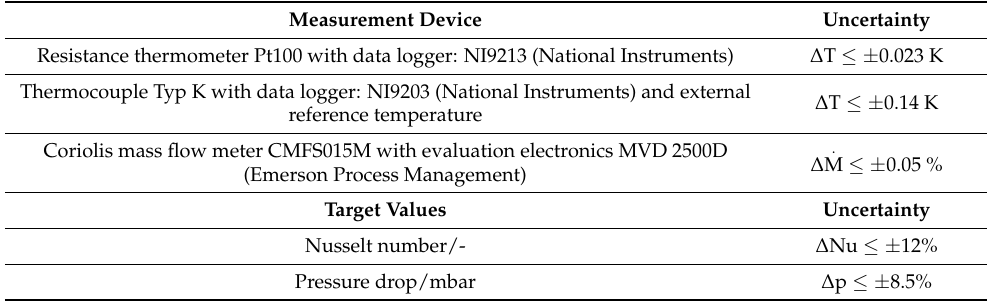
Table 2. Uncertainty of all measuring devices and resulting uncertainties of target values heat transfer and pressure drop.